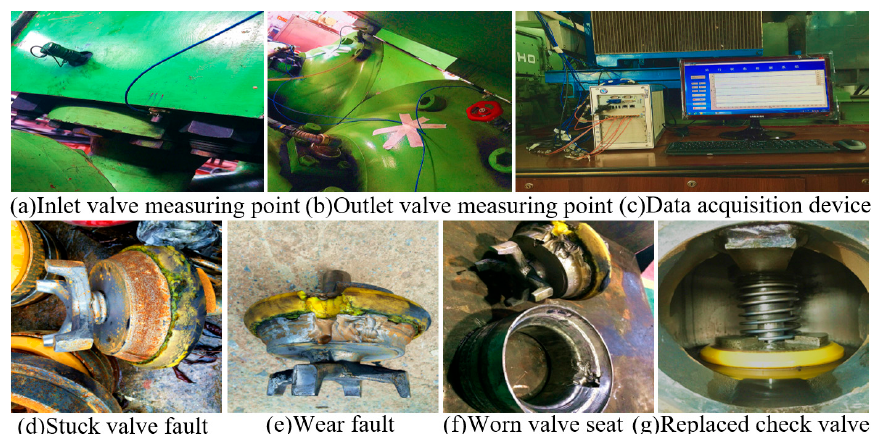
Figure 9. Sensor measuring point, acquisition platform and fault check valve. ( a ) Inlet valve measuring point; ( b ) Outlet valve measuring point; ( c ) Data acquisition device; ( d ) Stuck valve fault; ( e ) Wear fault; ( f ) Worn valve seat; ( g ) Replaced check valve.